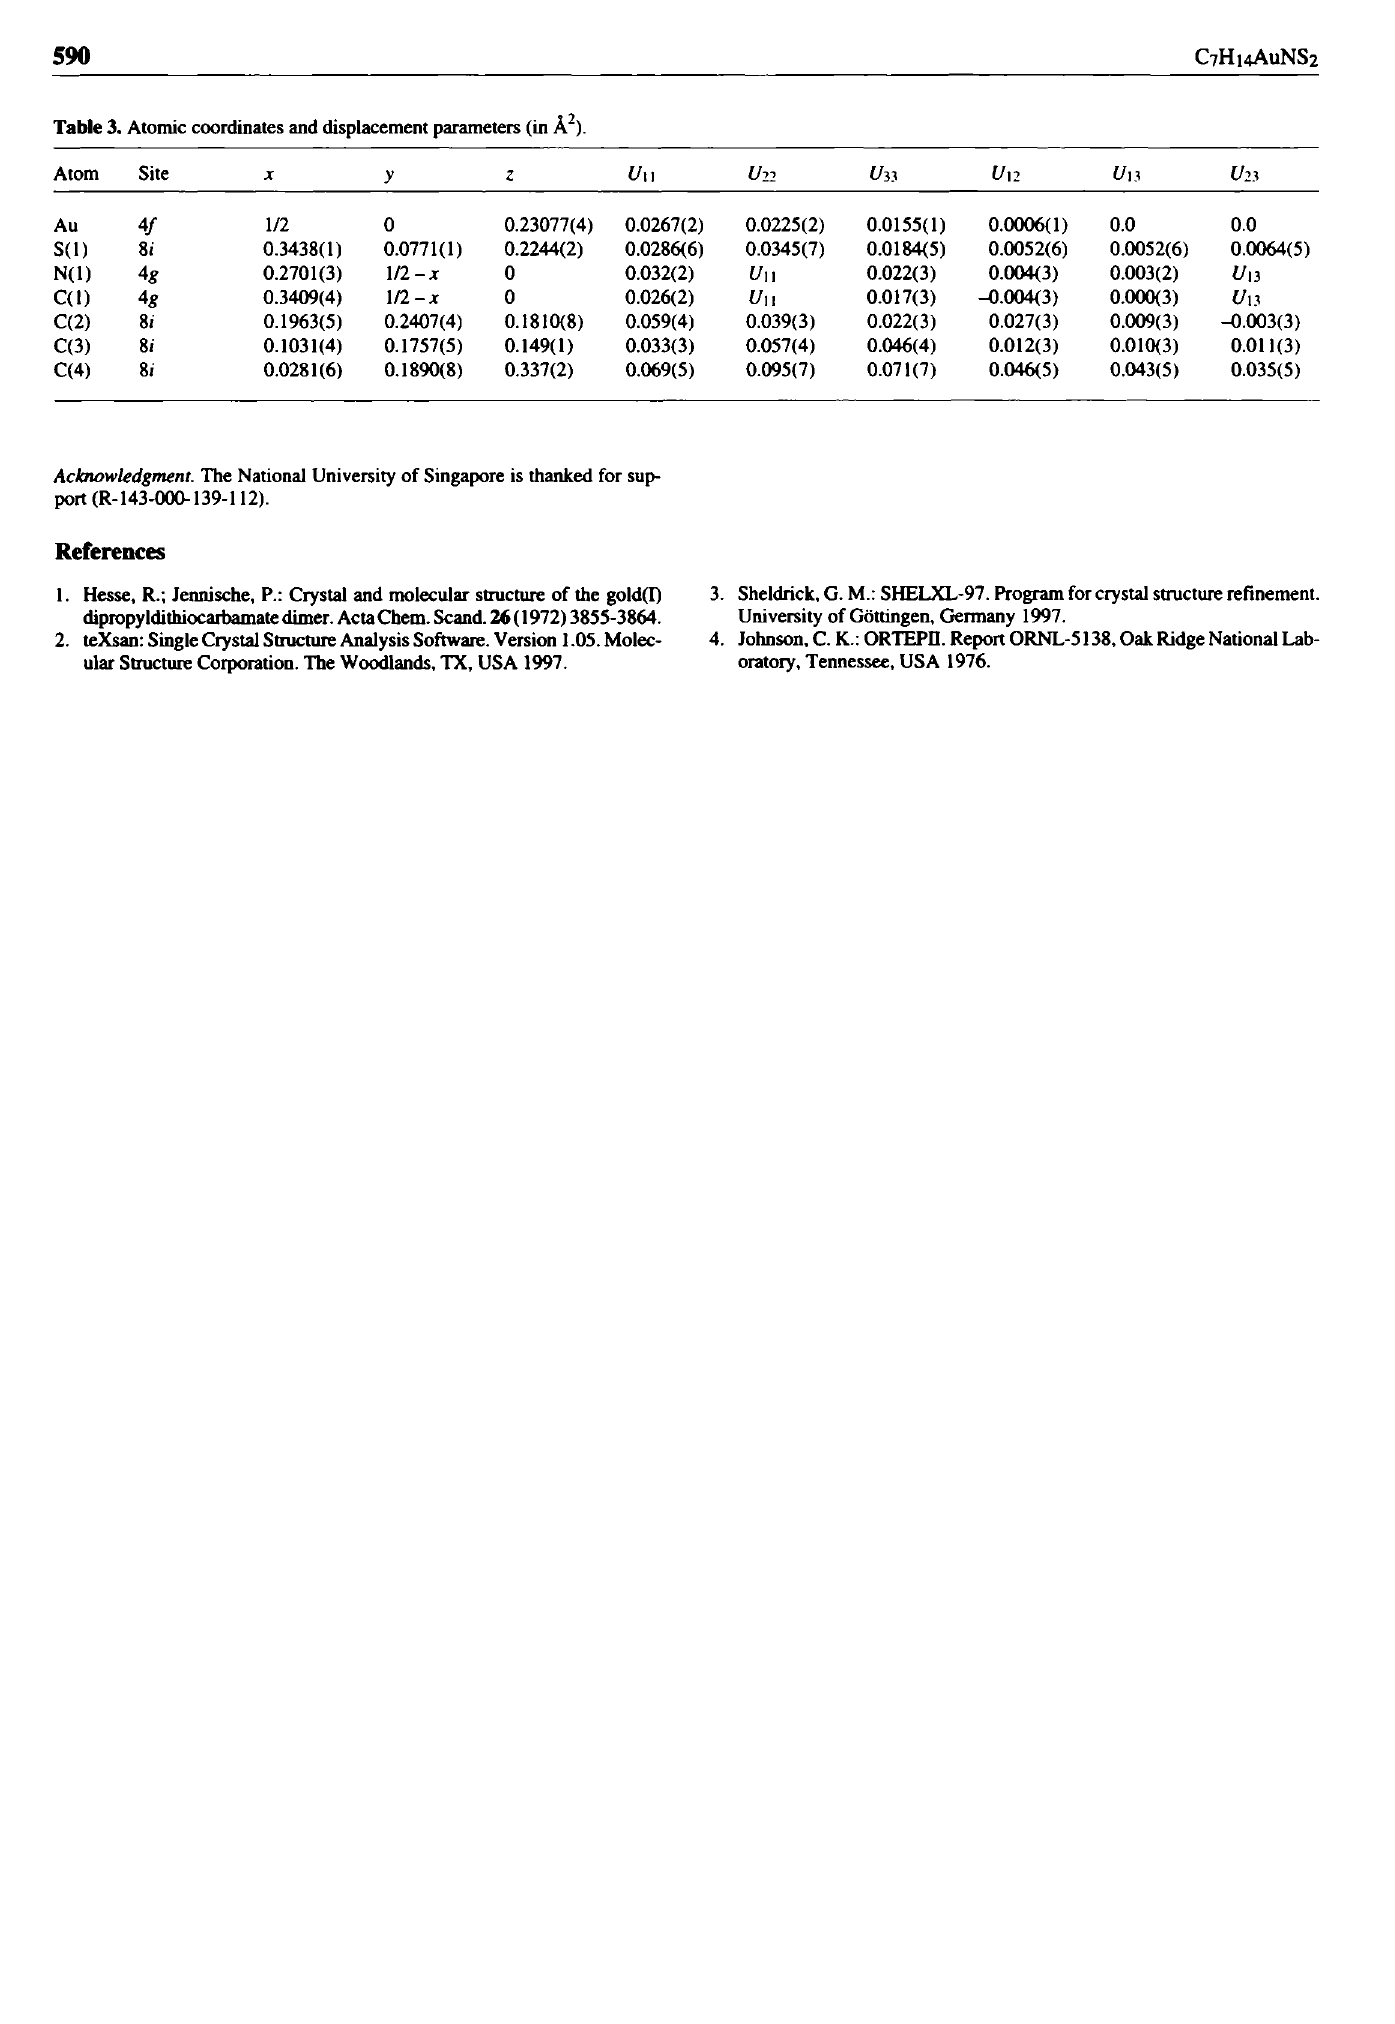
Table 3. Atomic coordinates and displacement parameters (in Â 2